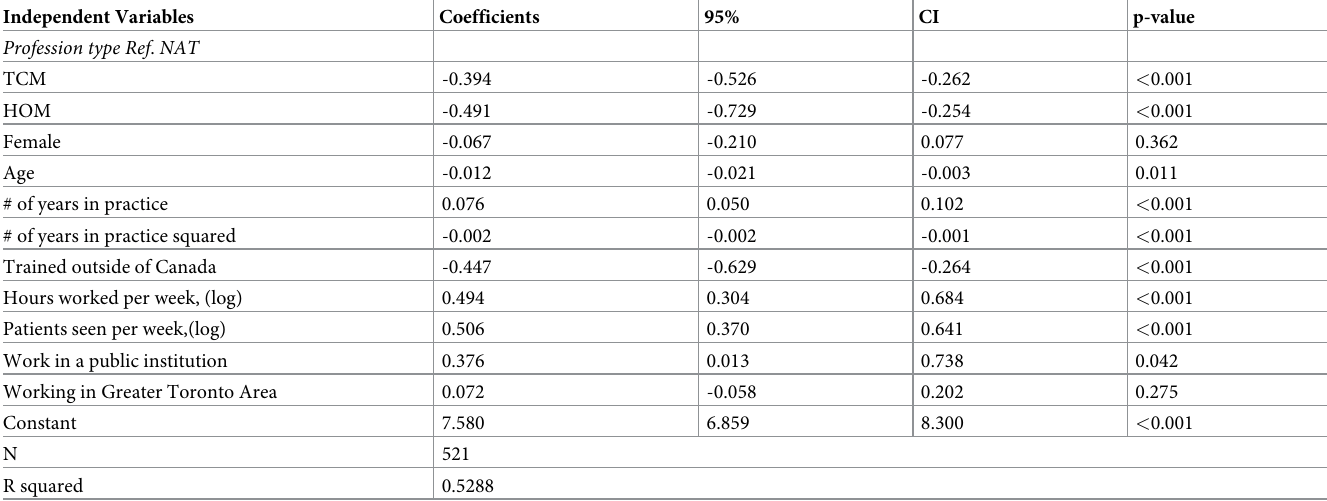
Table 6. Linear regression on log transformed